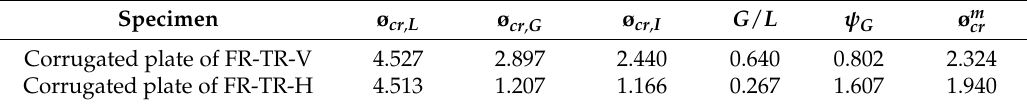
Table 2. Shear buckling strength of corrugated plates of the specimens (unit: × 10 5 kN/m 2 ). Specimen ø cr , L ø cr , G ø cr , I G / L ψ G ø m cr Corrugated plate of FR-TR-V Corrugated plate of